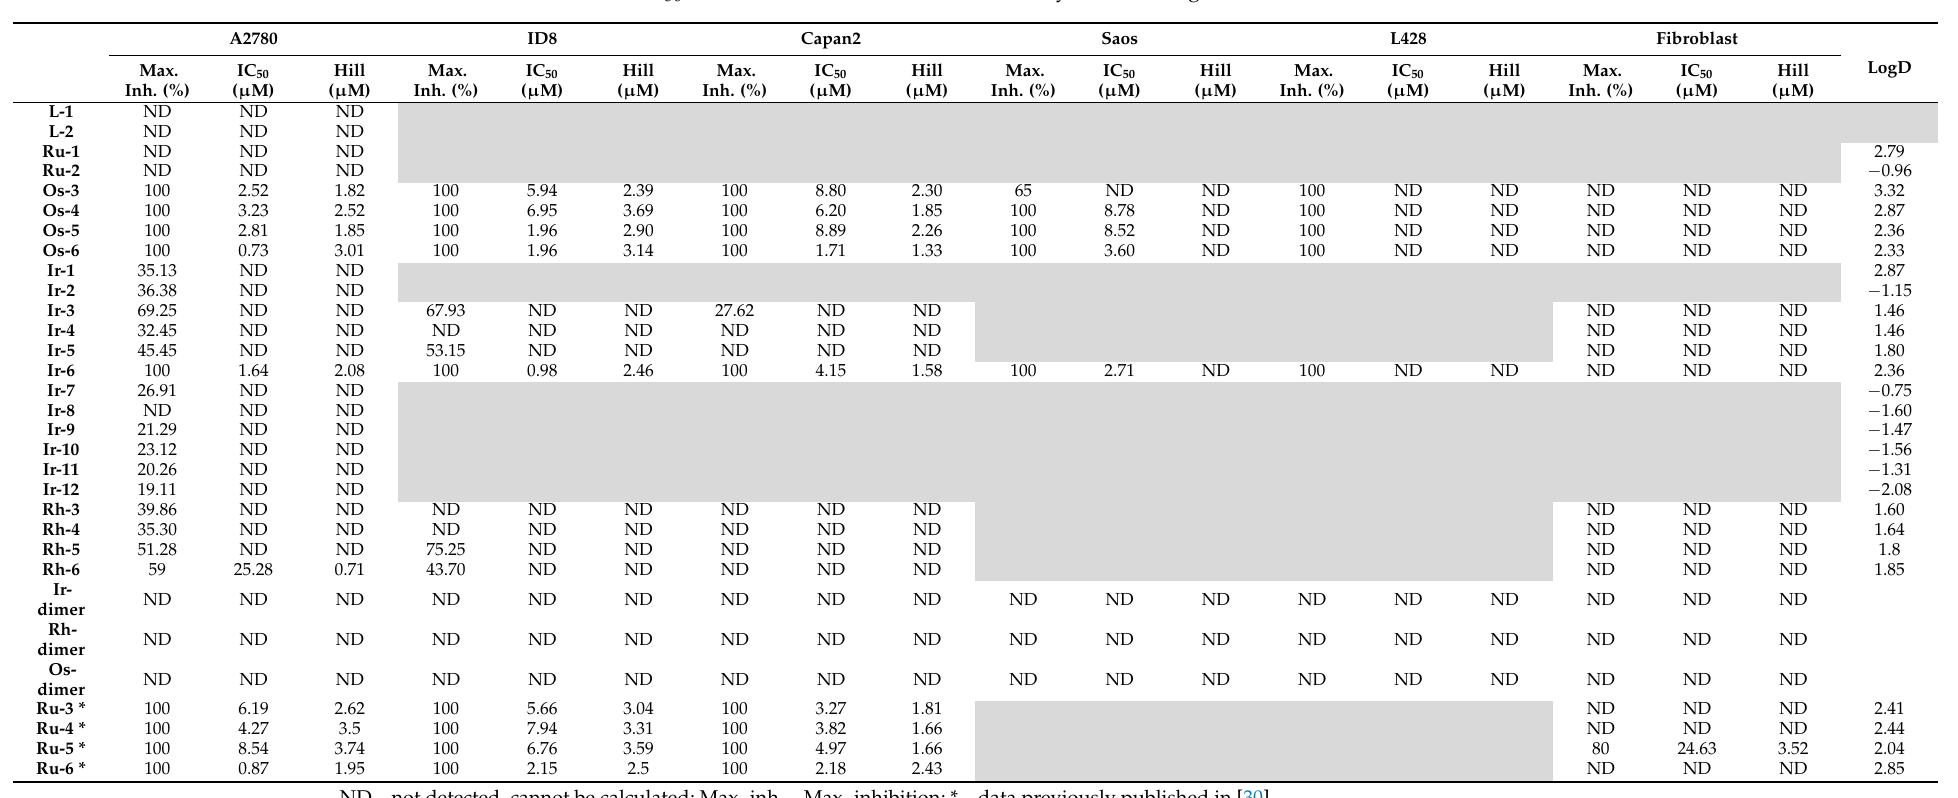
Table 5. Maximum inhibition, IC 50 , Hill coefficient values from SRB assays, and the logD